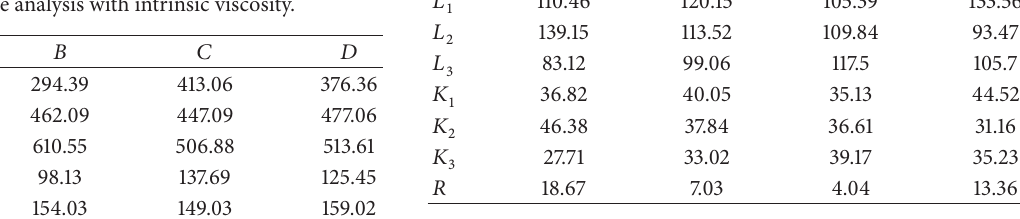
Table 4: Range analysis with intrinsic viscosity.